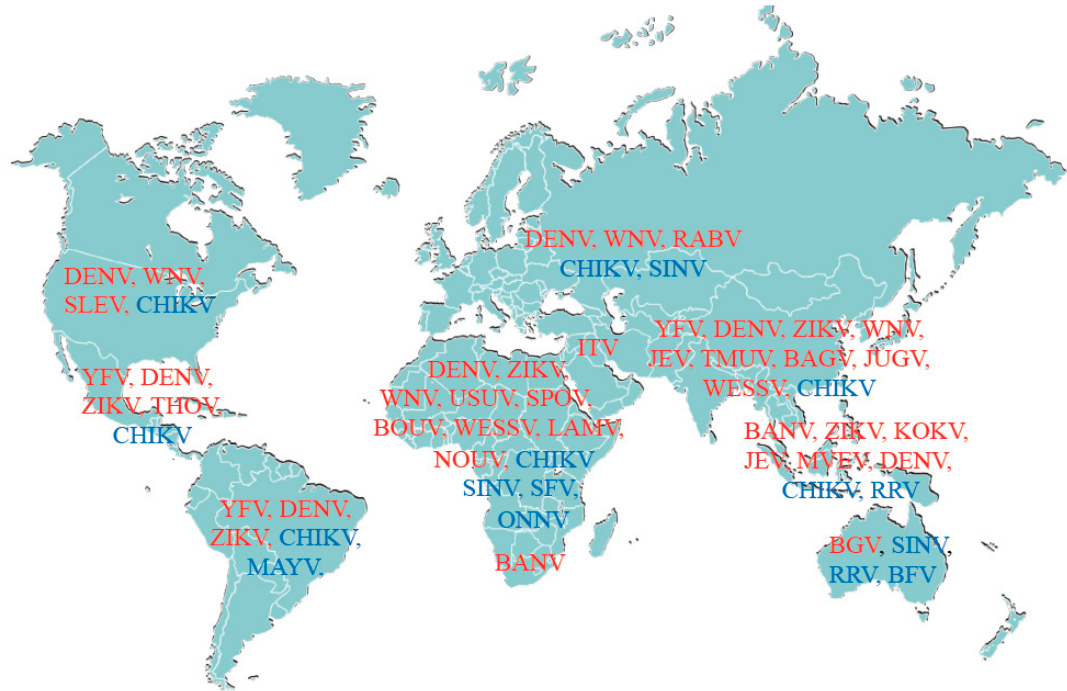
Figure 1. Non-exhaustive alphabetic list of flaviviruses (in red) and alphaviruses (in blue) and their geographical localization. Flaviviruses: Bagaza virus (BAGV), Bamaga virus (BGV), Banzi virus (BANV), Bouboui virus (BOUV), Dengue virus (DENV), Israel Turkey meningoencephalomyelitis (ITV), Japanese encephalitis virus (JEV), Jugra virus (JUGV), Kokobera virus (KOKV), Lamni virus (LAMV), Murray Valley encephalitis virus (MVEV), Nouanamé virus (NOUV), Rabensburg virus (RABV), Saint Louis encephalitis virus (SLEV), Spondweni virus (SPOV), Tembusu virus (TMUV), T’Ho virus (THOV), Usutu virus (USUV), Wesselsbron virus (WESSV), West Nile virus (WNV), yellow fever virus (YFV) and Zika virus (ZIKV). Alphaviruses: Barmah forest virus (BFV), Chikungunya virus (CHIKV), Mayaro virus (MAYV), O’nyong-nyong virus (ONNV), Ross River virus (RRV), Semliki forest virus (SFV) and Sindbis virus (SINV).